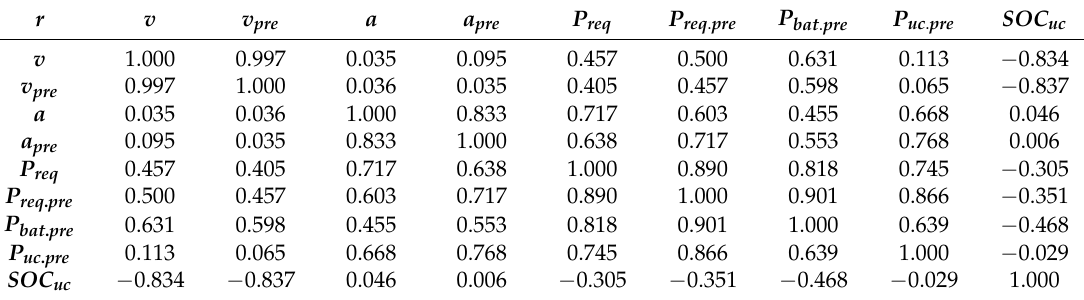
Table 4. Correlation coefficients between characteristic variables.